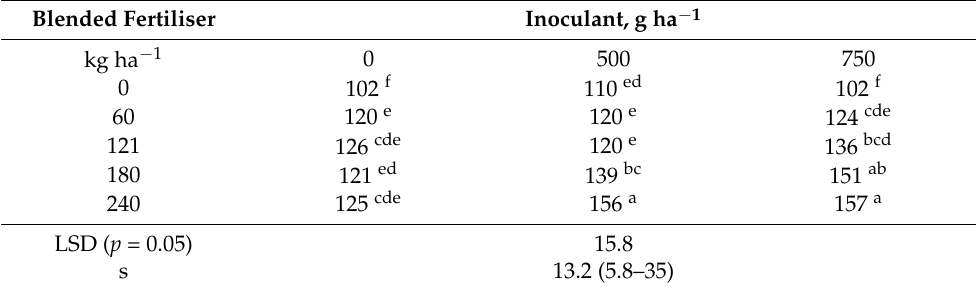
Table 7. Plant height (cm) affected by combined application of blended fertiliser and the inoculant. Blended Fertiliser